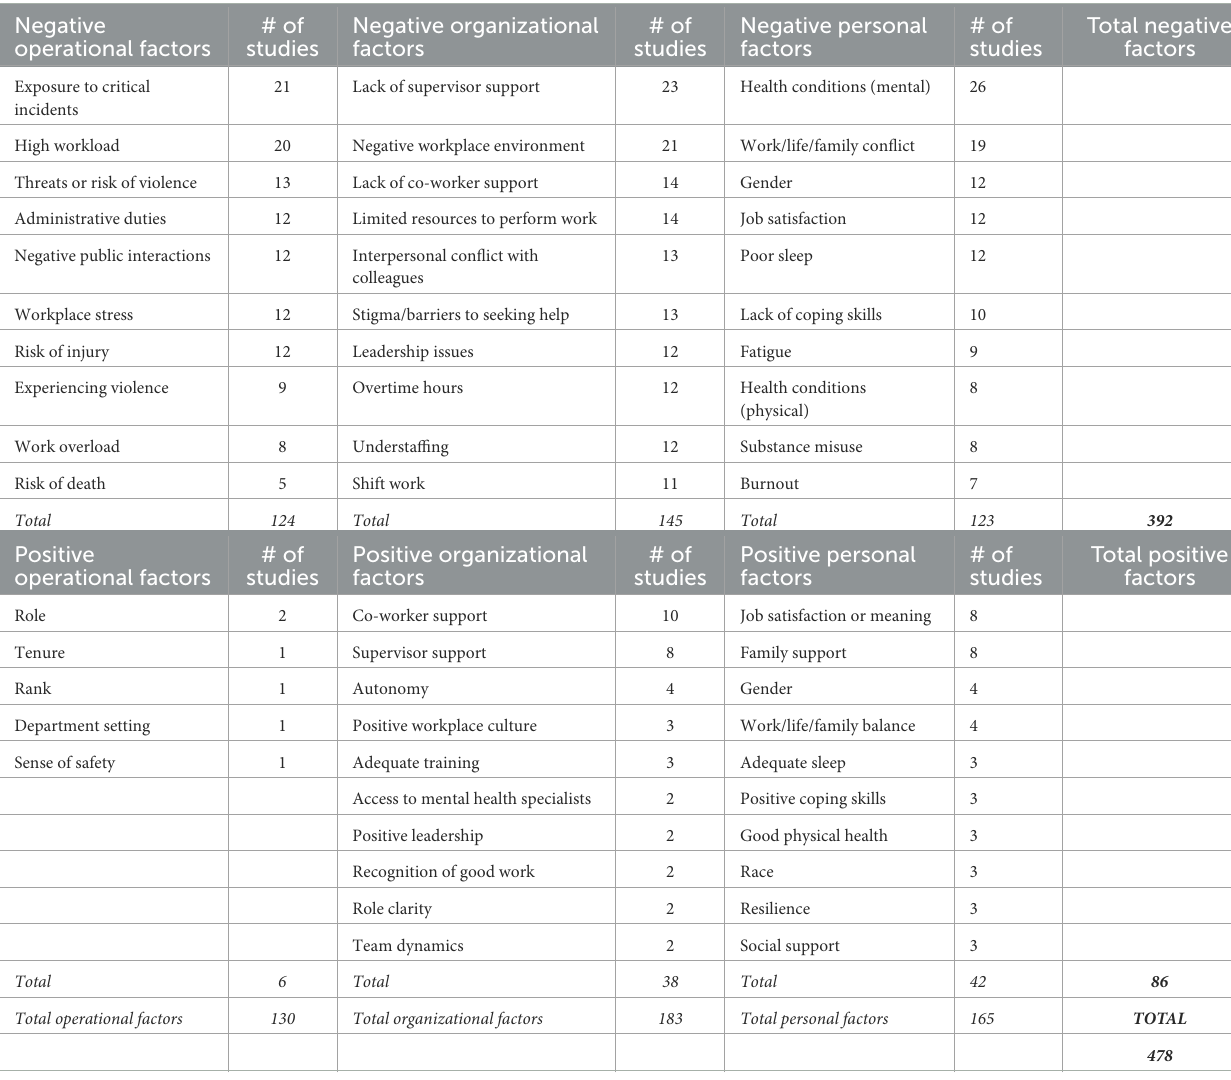
TABLE 1 Summary of the top 10 factors known to impact PSP mental health [as in Edgelow et al.